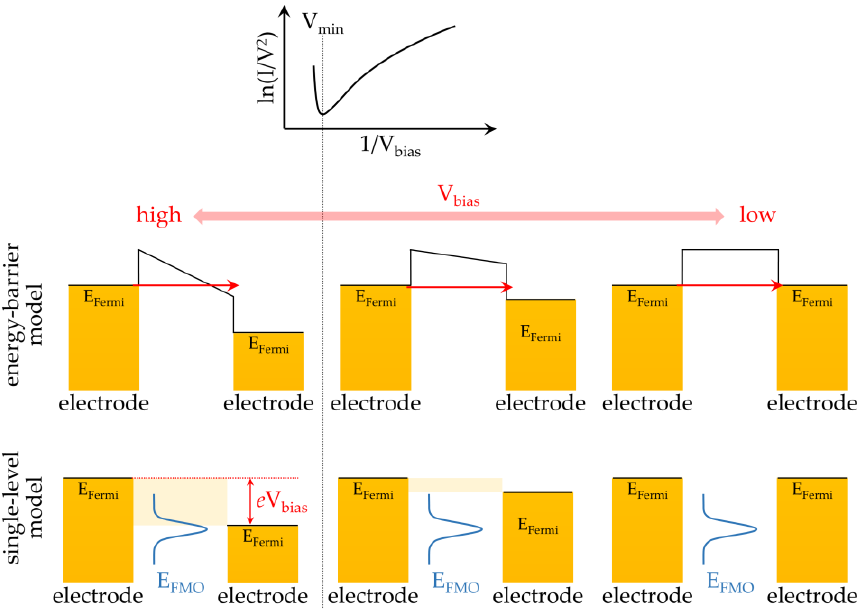
Figure 3. Interpretation of the trace of transition voltage spectroscopy (TVS). An important feature of a TVS spectrum is its minimum point (V min ), which is described by the energy-barrier model (middle panels) and single-level model (bottom panels) for electron transport across an ensemble junction or a single-molecule junction, respectively. For the middle panels, the molecular ensemble is viewed as an energy barrier whose shape is determined by the applied bias (V bias ). The shape of the energy barrier changes from a trapezoidal one to a triangular one when V bias > V min , suggesting the transition of the transport mechanism from tunneling to field emission (or Fowler–Nordheim tunneling). For the bottom panels, the transport is dominated by the frontier molecular orbital and is described by a transmission peak. When V bias > V min , the bias window (beige-shaded area) covers a certain fraction of the proximal transmission peak. The value of V min increases as the position of E FMO shifts away from the Fermi level (E Fermi ), showing that V min is a parameter indicating the degree of ELA.